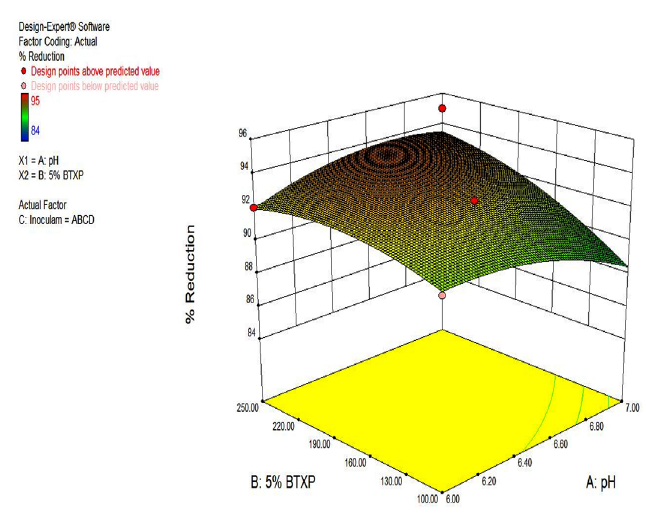
Fig. 3. Effect of pH and BTXP concentration on BTXP